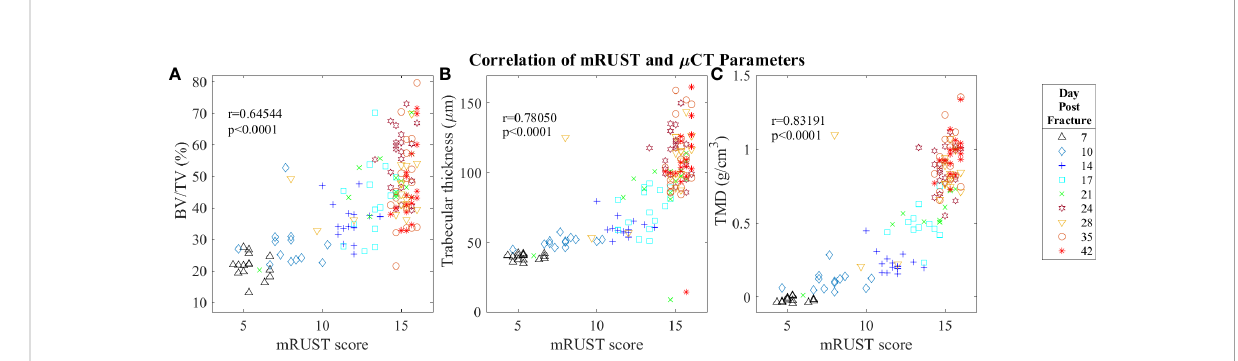
FIGURE 7 Symbol and color plot of mRUST correlations with (A) BV/TV (%), (B) Trabecular thickness ( m m), and (C) Tissue Mineral Density (g/cm) 3 . Each point represents an individual mouse. .